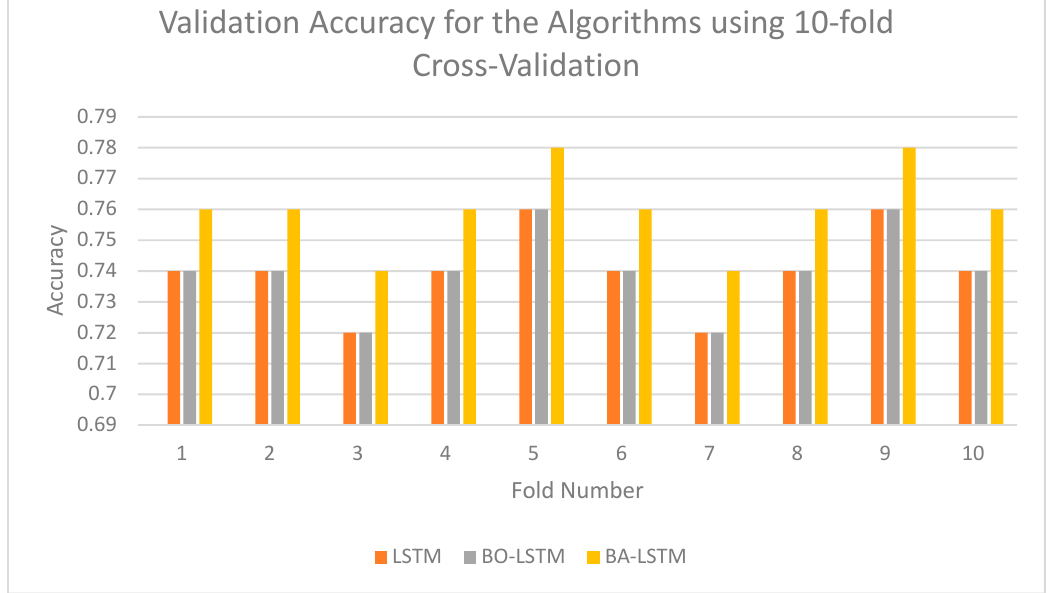
Figure 19. Validation accuracy for the algorithms using 10-fold cross-validation (engine dataset).